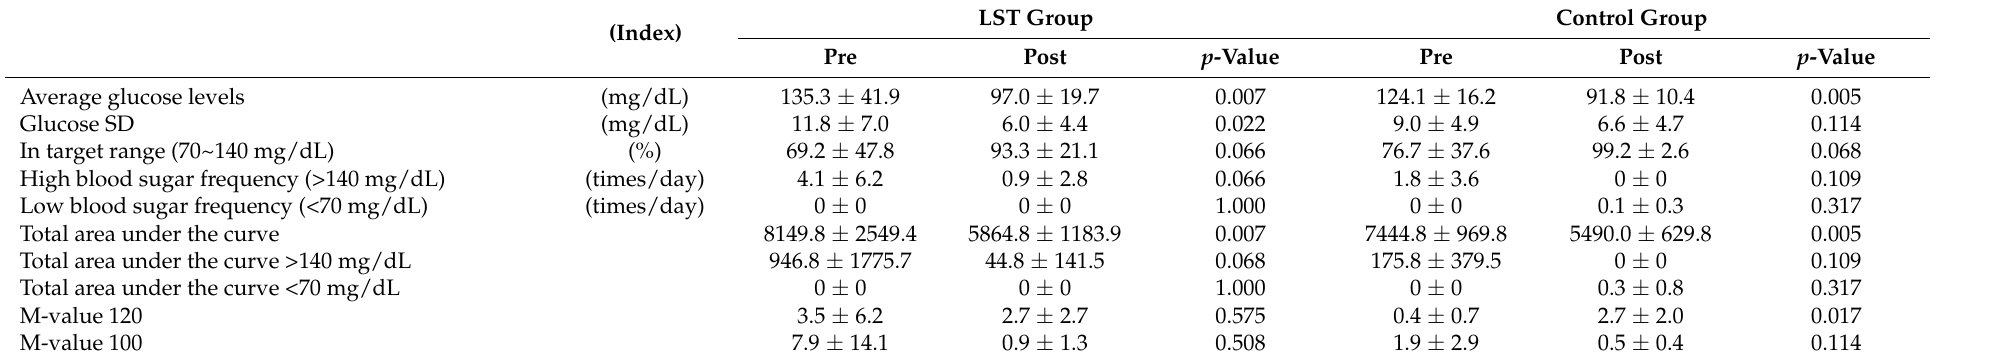
Table 4. A comparison of pre-LST (10:00–10:40 a.m.) and post-LST (10:40–11:40 a.m.) physiological